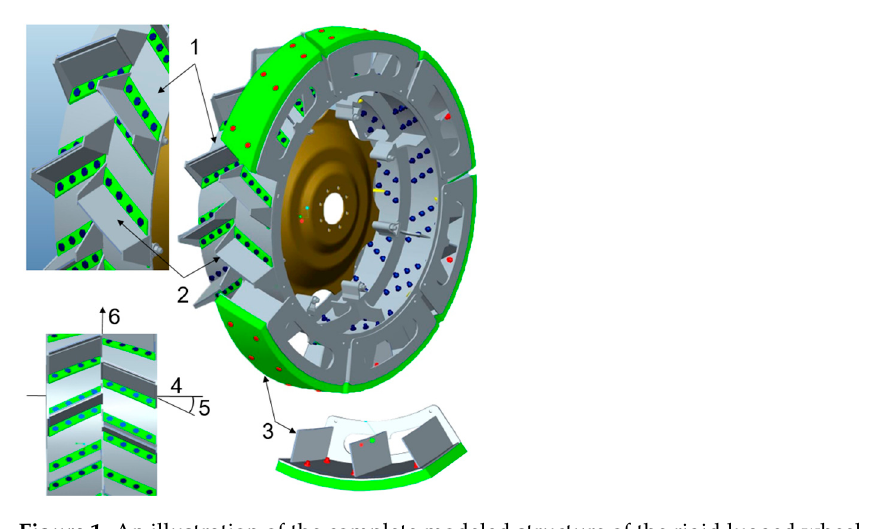
Figure 1. An illustration of the complete modeled structure of the rigid lugged wheel.